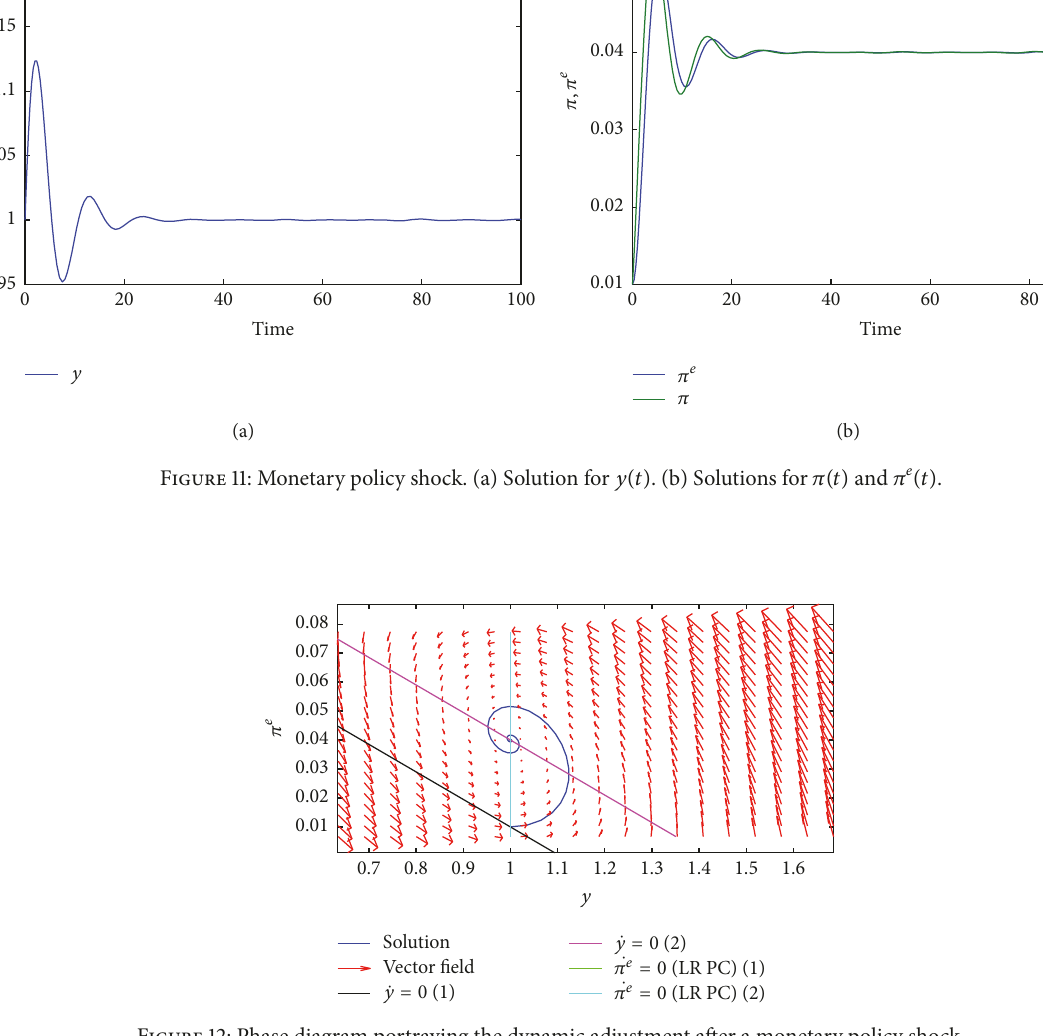
Figure 12: Phase diagram portraying the dynamic adjustment after a monetary policy